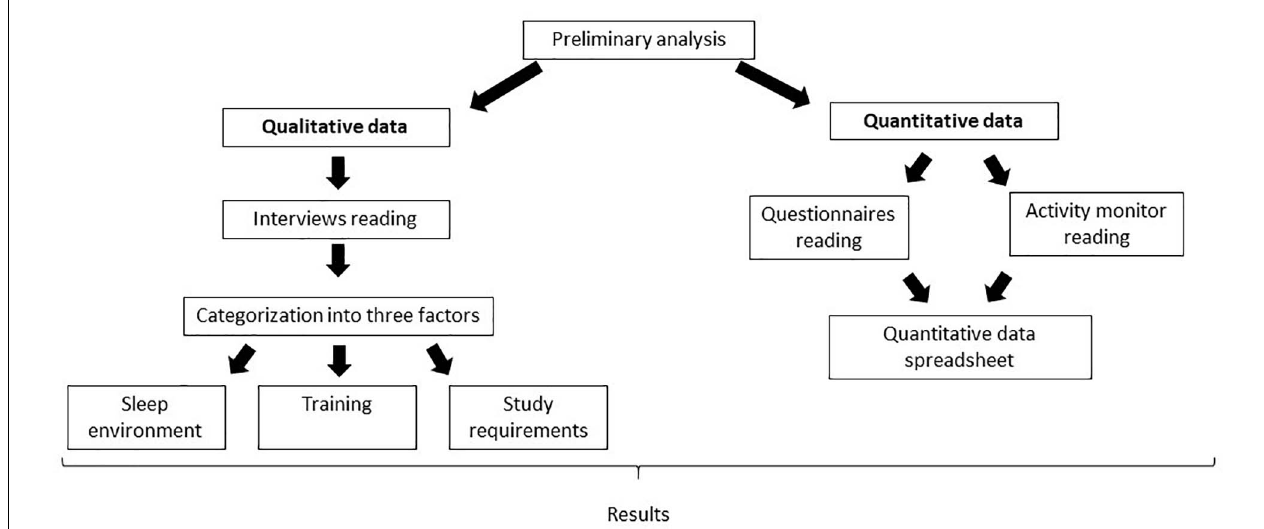
FIGURE 1 | Methodological approach used to combine qualitative and quantitative data.